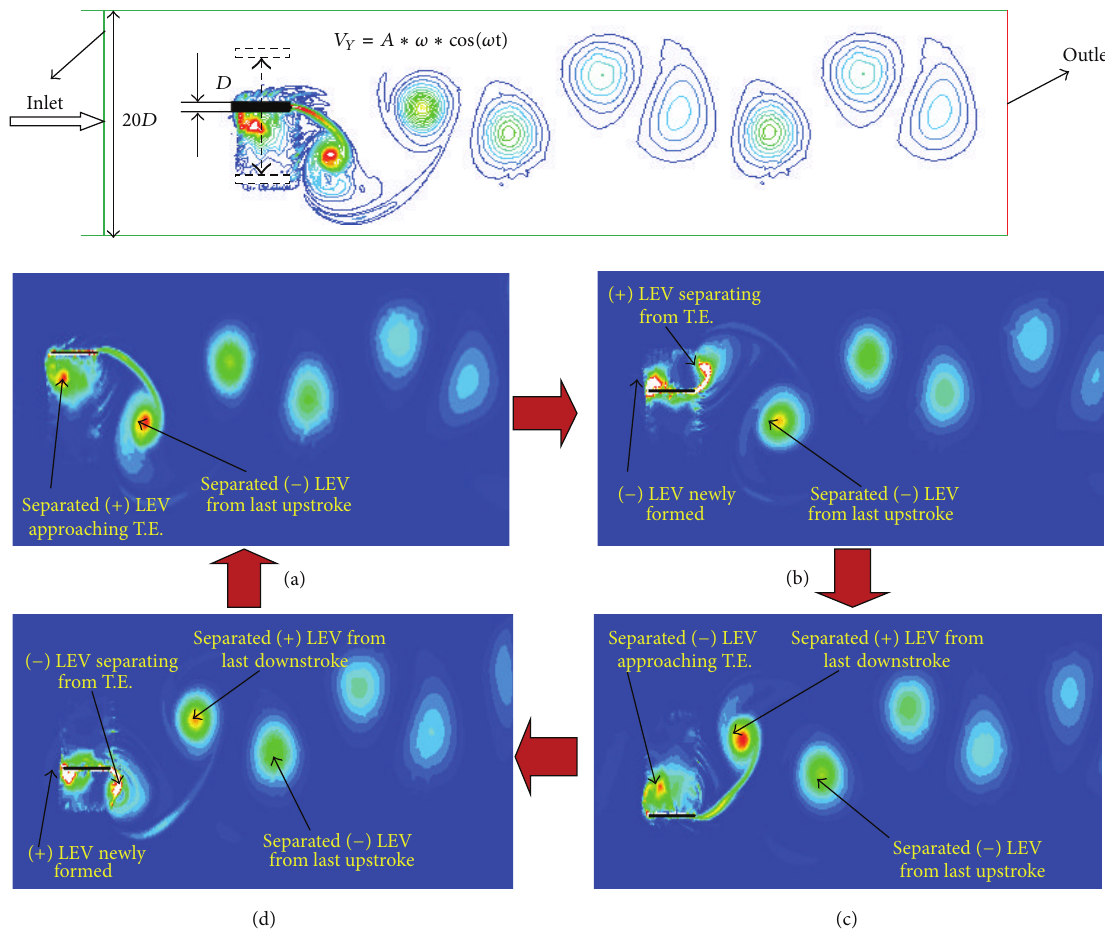
Figure 7: 2D vortex shedding on the chordwise direction at the different positions. (a) Wing at the upmost position: downstroke starts. (b) Wing at the neutral position, during downstroke. (c) Wing at the bottom most position: upstroke starts. (d) Wing at the neutral position, during upstroke.